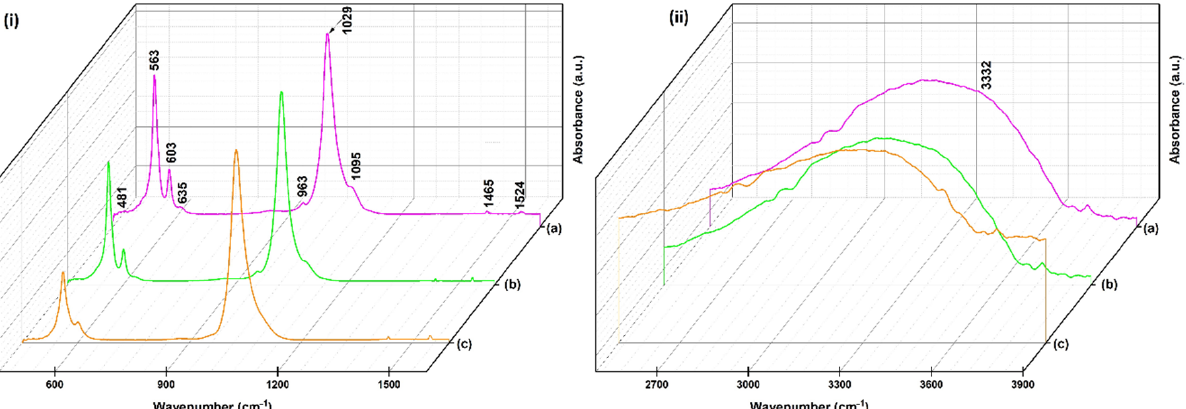
Figure 2. Three-dimensional representation of absorbance FTIR spectra obtained on HapCh (a), 8MgHApCh (b) and 30MgHApCh (c) composite coatings. The FTIR spectra are presented in 400–1600 cm − 1 ( i ) and 2500–3900 cm − 1 ( ii ) spectral range.